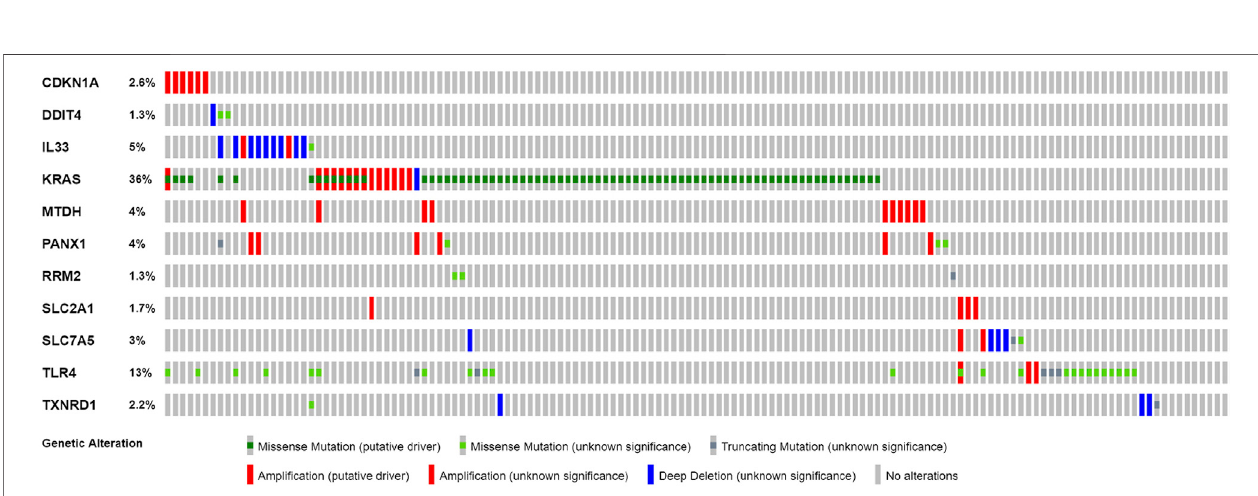
Frontiers in Genetics |